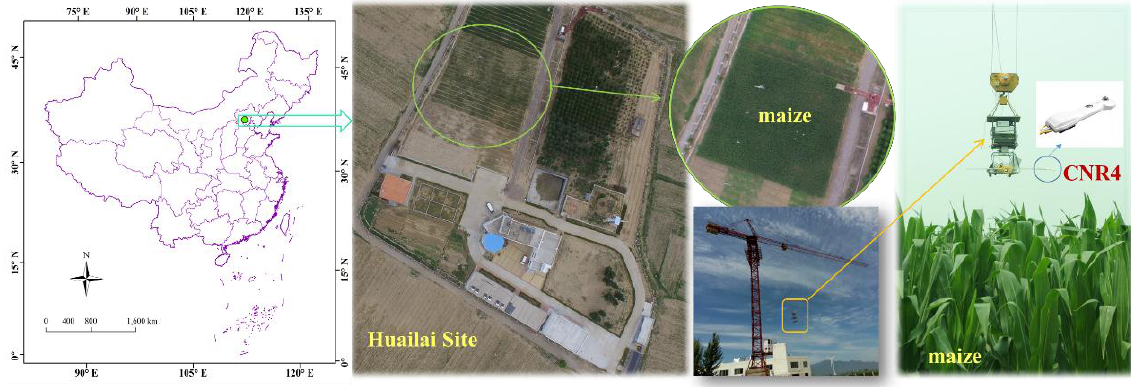
Figure 15. Position and aerial view photograph of the Huailai site.